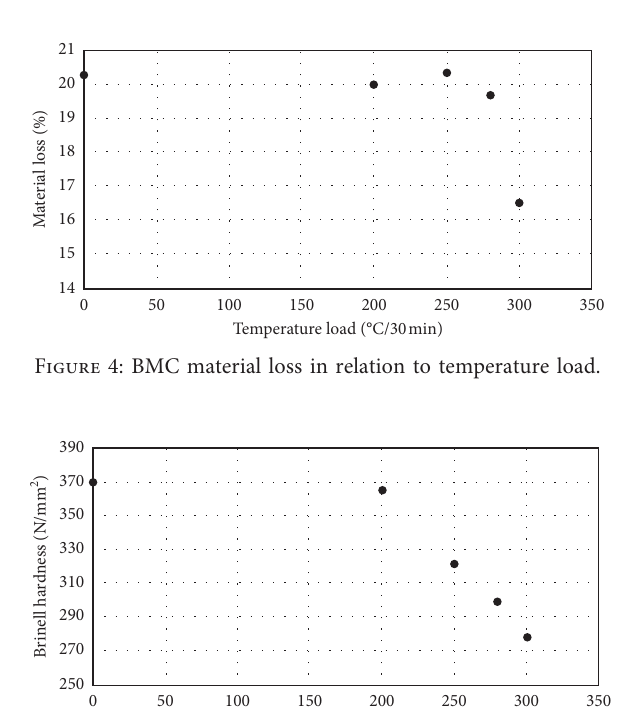
Figure 3: Details of binding zone C-O-C 1147cm − 1 .